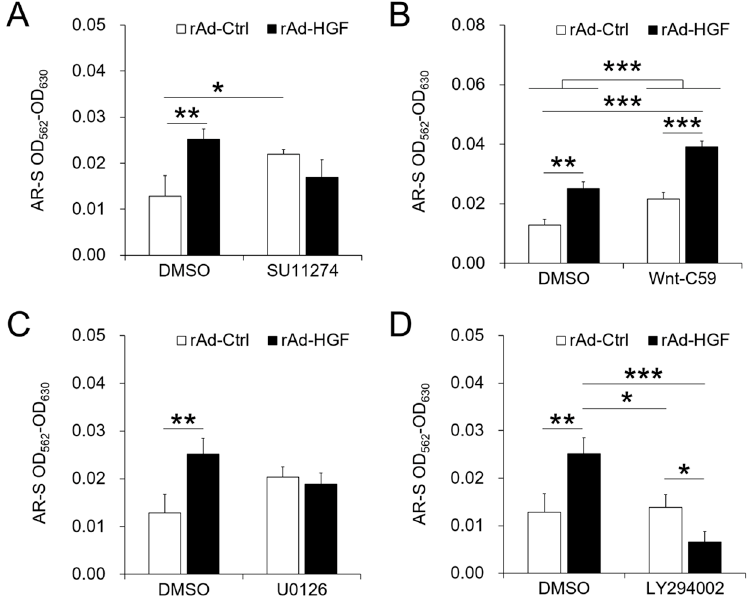
Figure 5. Roles of signaling pathways in osteogenesis of hi-BMSCs infected with recombinant adenoviruses. Human BMSCs were cultured in the osteogenic differentiation medium and treated with signal pathway inhibitors or DMSO before infection. Two weeks later, cell osteogenesis was detected using AR-S staining ( A – D ). * p < 0.05, ** p < 0.01, *** p < 0.001. The experiment has been replicated three times with similar results, and the representative results were